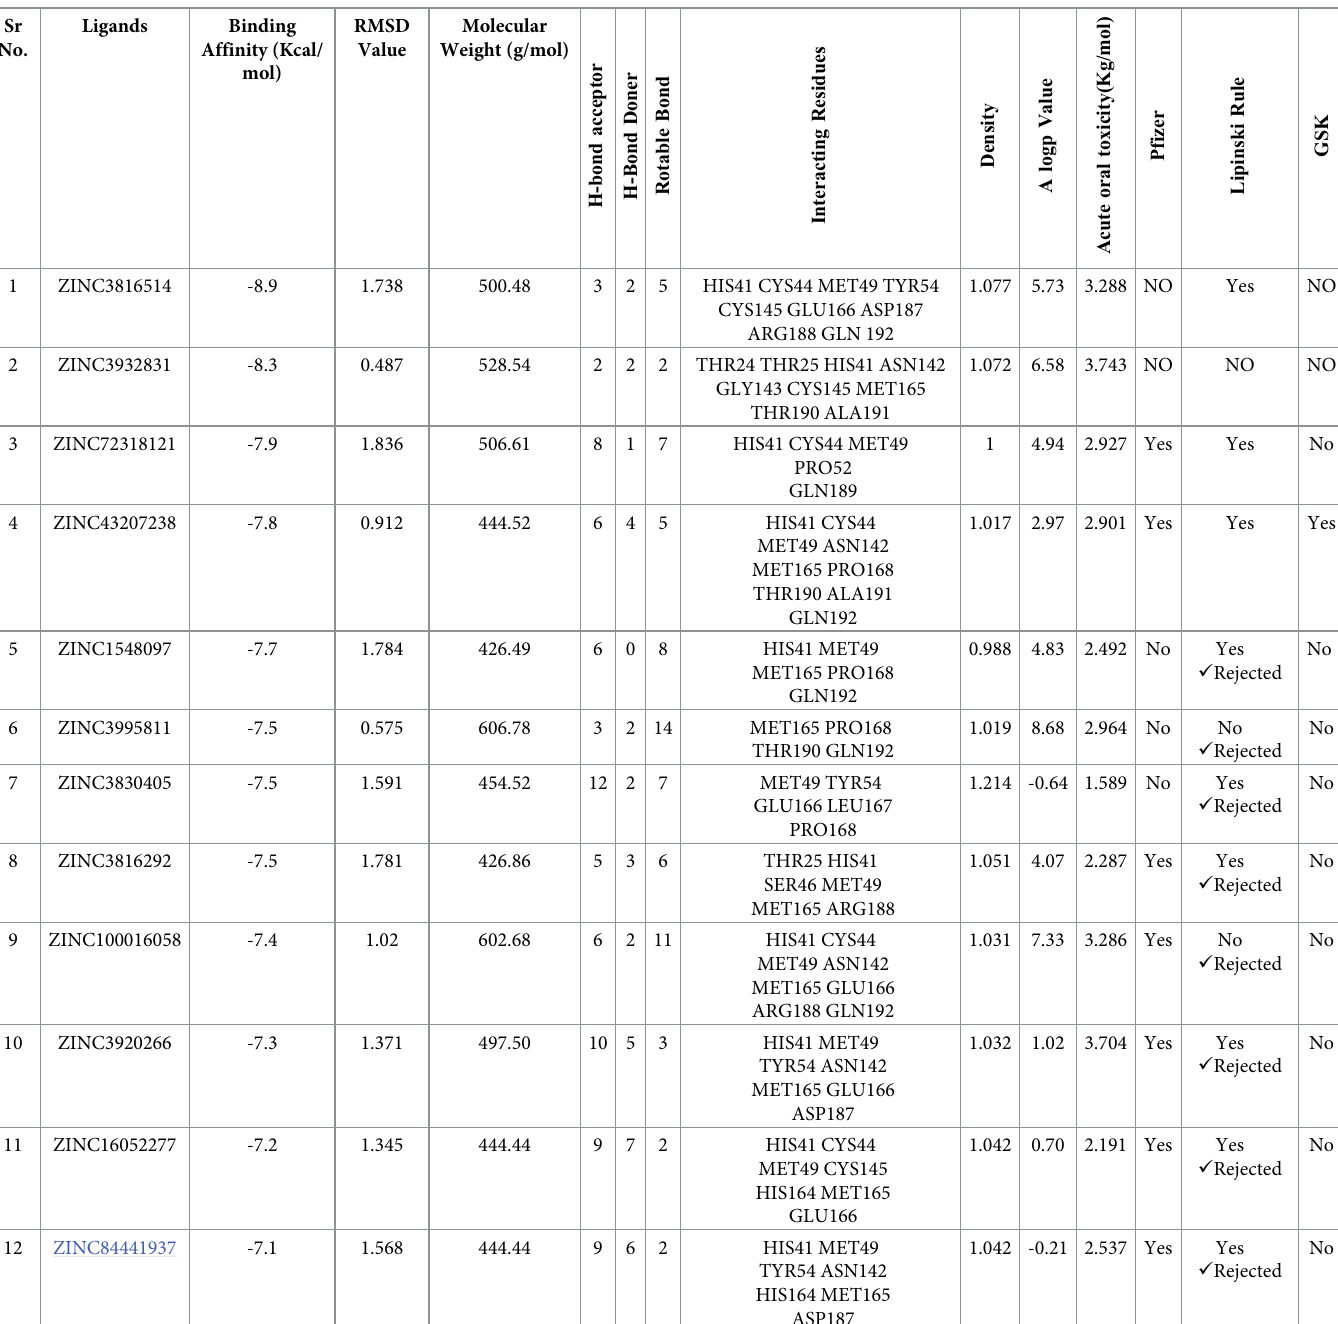
Table 4. Drug like properties and comparative molecular docking analyses of selected compounds scrutinize through virtual screening. Sr